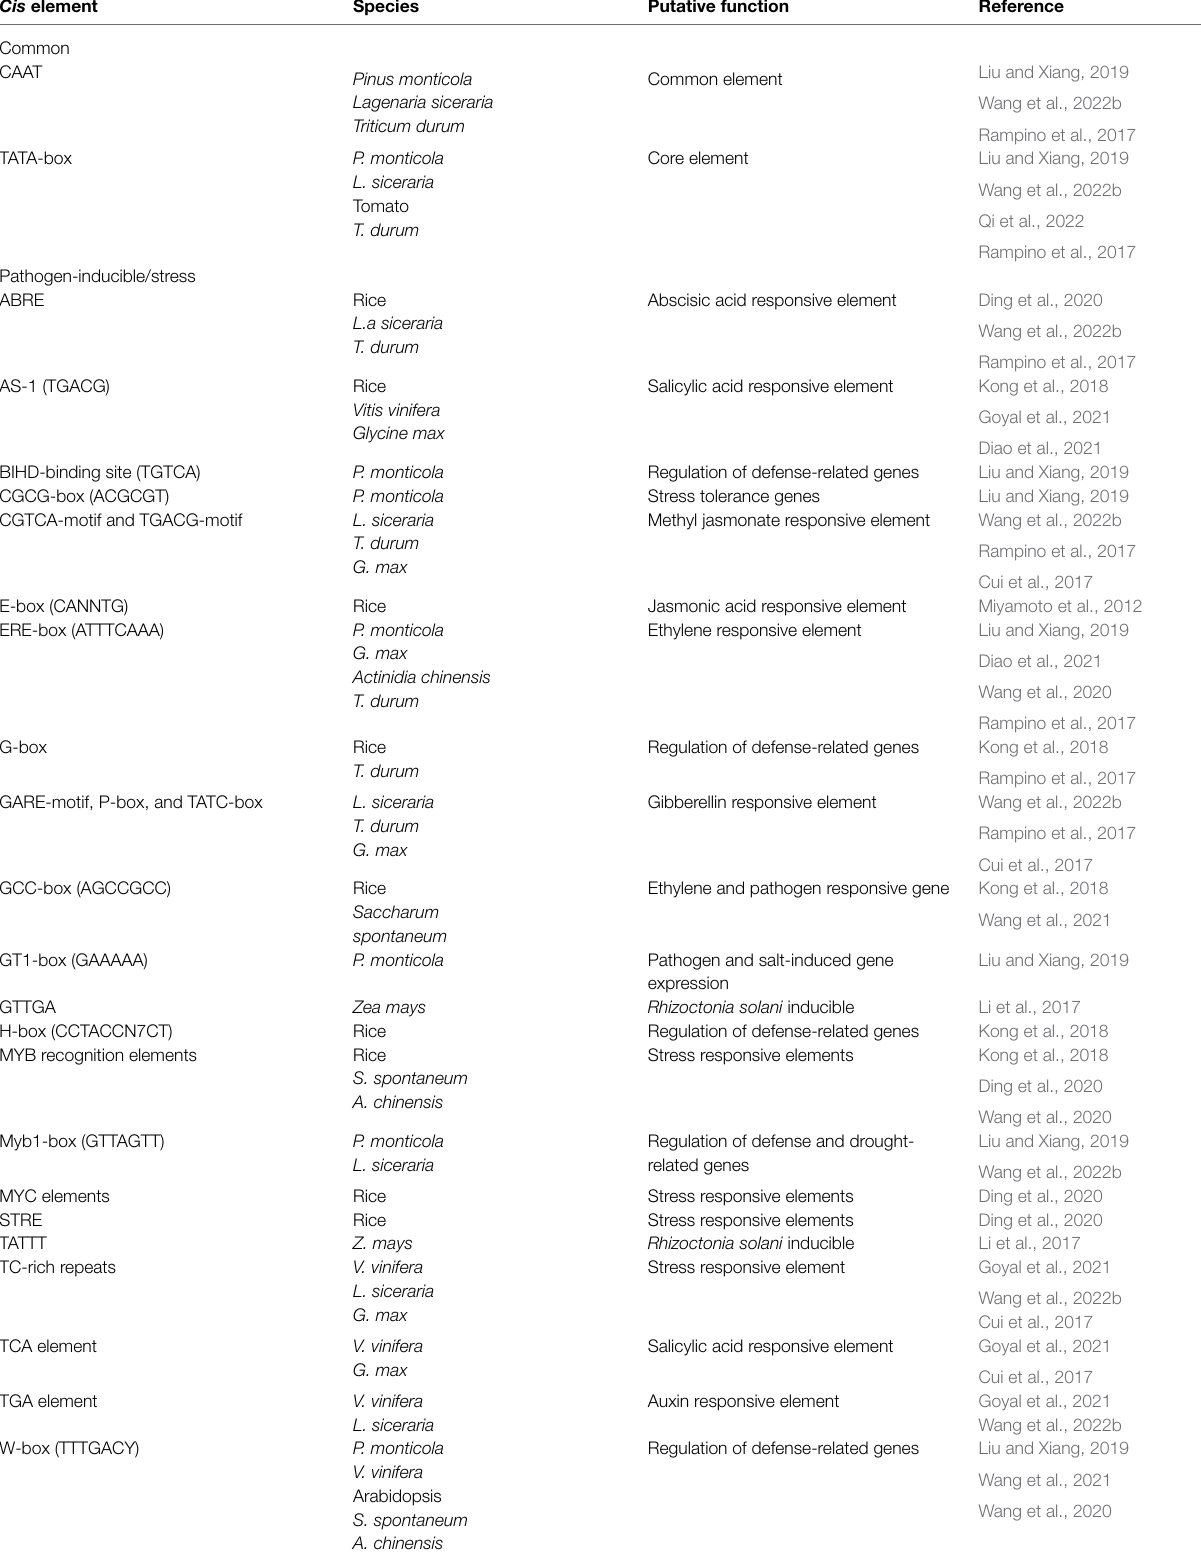
TABLE 1 | Cis elements identified in promoter sequences of plant NLR